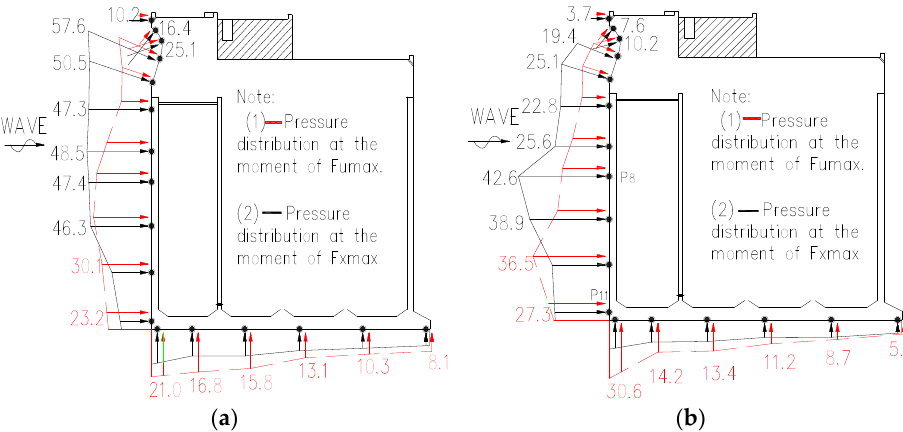
Figure 8. Layout of the measuring points and definition of the coordinate system (unit: m): ( a ) arrangement of the wave height measuring points; ( b ) arrangement of the pressure measuring points.